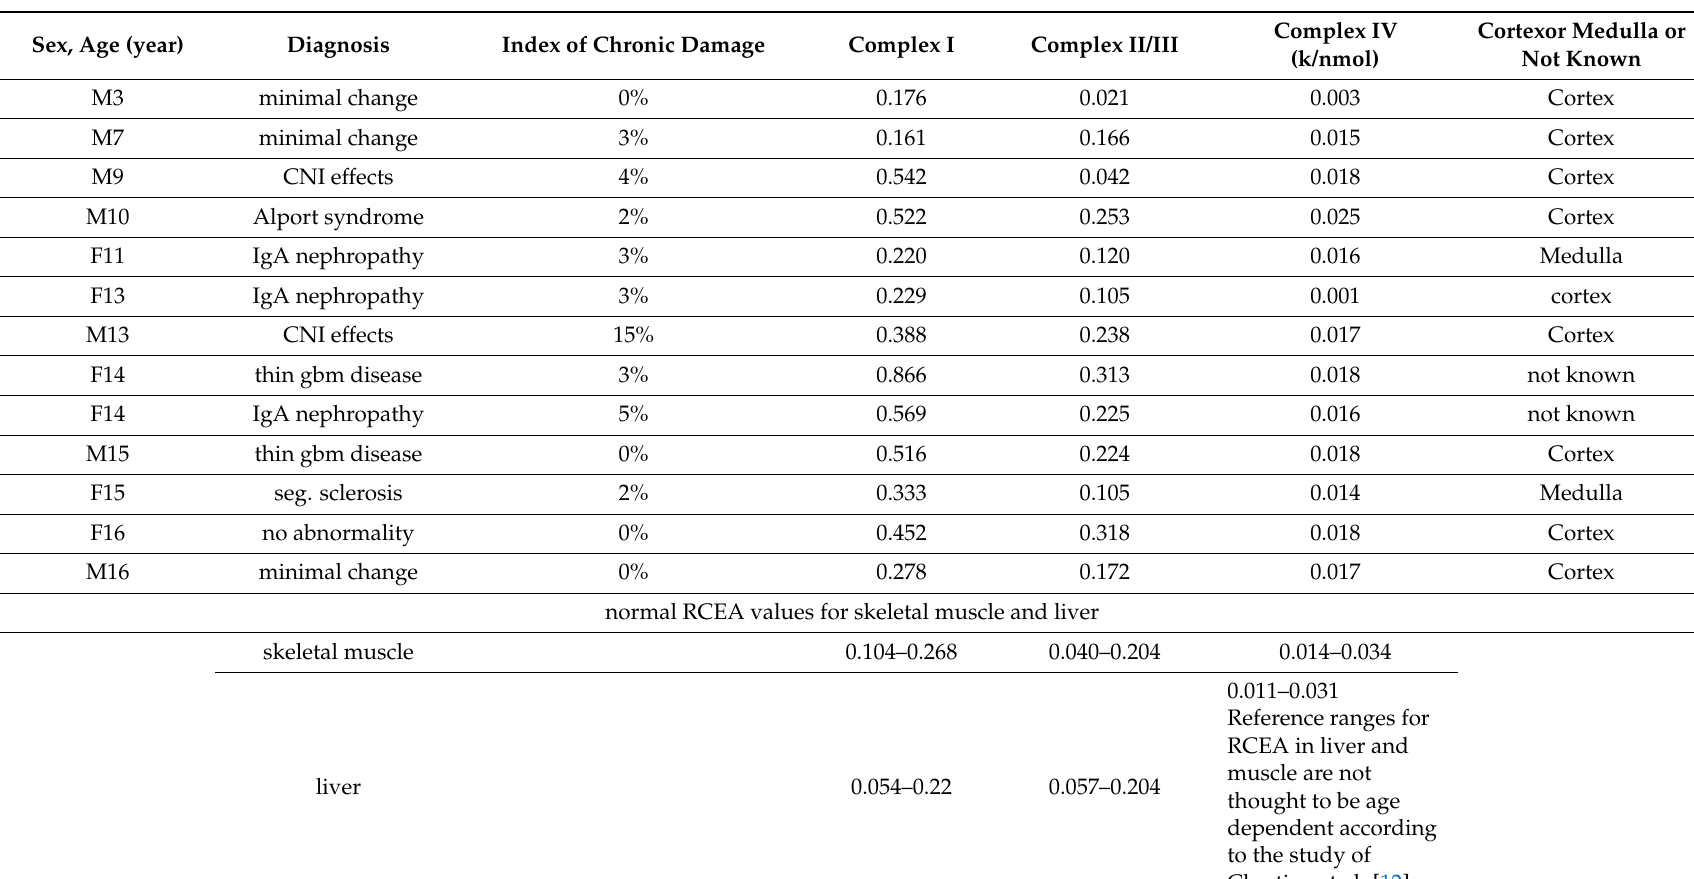
Table 1. Clinical details, index of chronic damage, and assay of respiratory chain enzyme activities (RCEA) in cortex or medulla, if site of tissue known. RCEA are expressed as a ratio of citrate synthase activity. Normal RCEA for skeletal muscle and liver are included for comparison